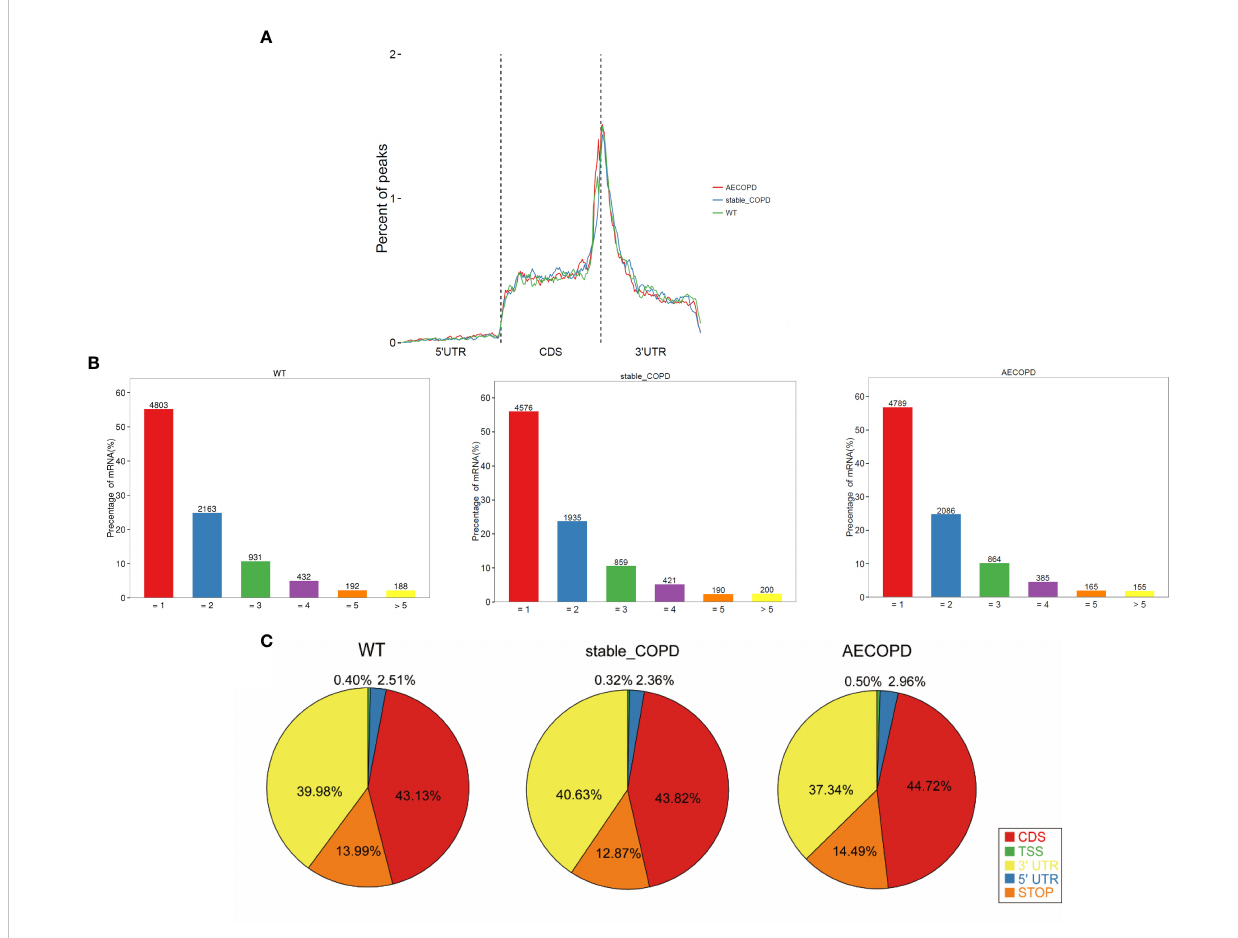
FIGURE 5 Distribution of m6A methyl groups in the transcript: (A) m6A peaks enriched with transcripts, wherein a transcript was separated into 5 ′ -UTR, coding sequence, and 3 ′ -UTR; (B) proportion of gene-processing m6A peaks with different numbers; (C) pie chart shows the percentage of m6A peak in the fi ve segments of transcript. The m6A peak was most enriched in the CDS